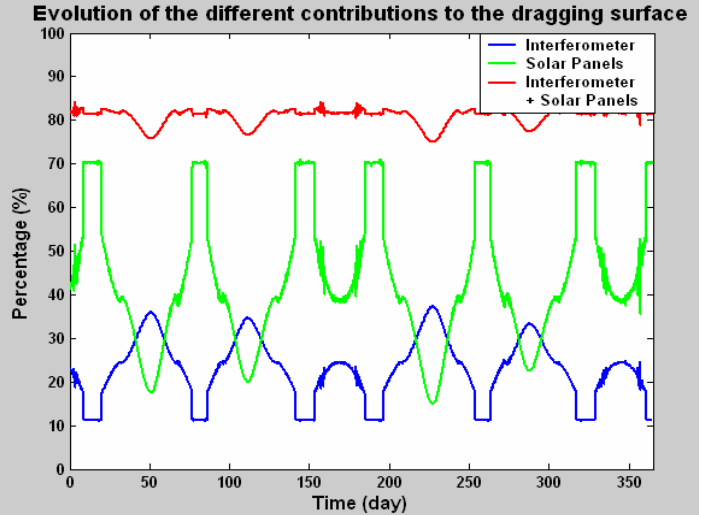
Figure 11. Evolution of the different contributions to the overall satellite surface